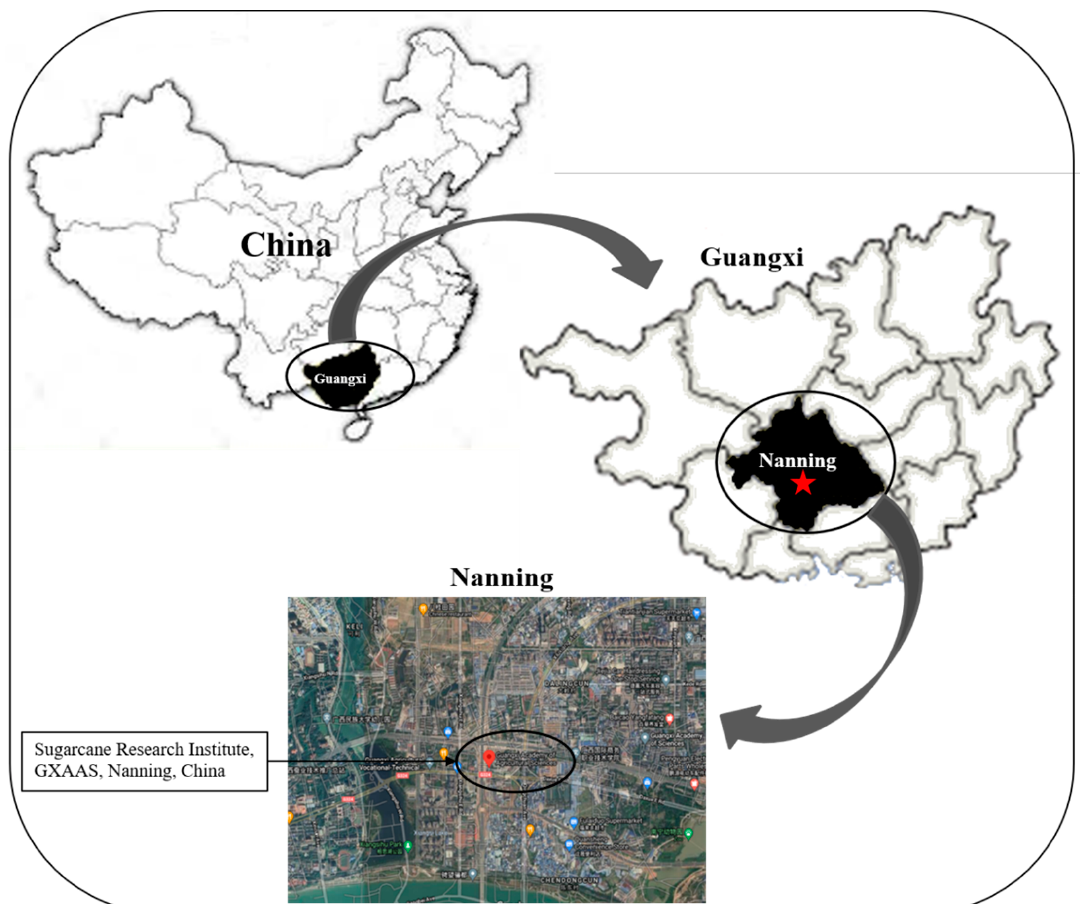
Figure 1. The location of the experimental site.